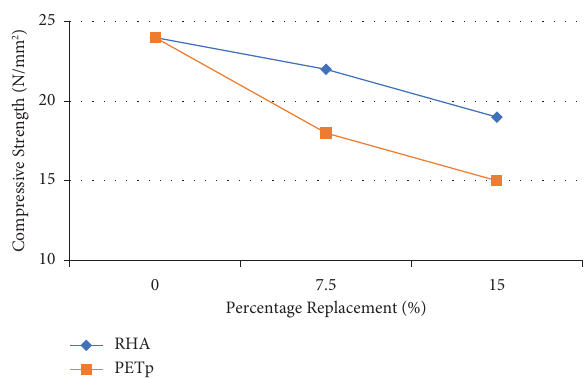
Figure 6: Efects of RHA and PETp on the compressive strength.